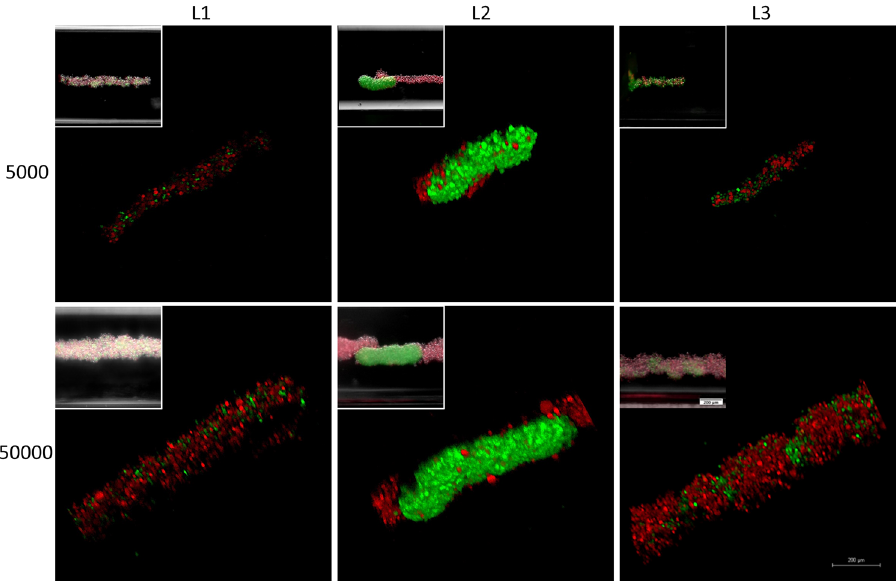
Figure 4. Cellular assembly of D1 ORL UVA eGFP and MDA-MB-231 dsRed cells under microgravity. Confocal and conventional fluorescence microscopy (upper left) images showing self-assembled coculture clusters formed with magnetic levitation (100 mM Gd-BT-DO3A) and different cell loading strategies; L1: simultaneously loading of MDA-MB-231 dsRed and D1 ORL UVA eGFP cells, L2: MDA-MB-231 dsRed cells onto D1 ORL UVA eGFP clusters formed with magnetic levitation and L3: D1 ORL UVA eGFP cells onto MDA-MB-231 dsRed clusters formed with magnetic levitation (total 5000 or 50000 cells). Scale bars: 200 μ